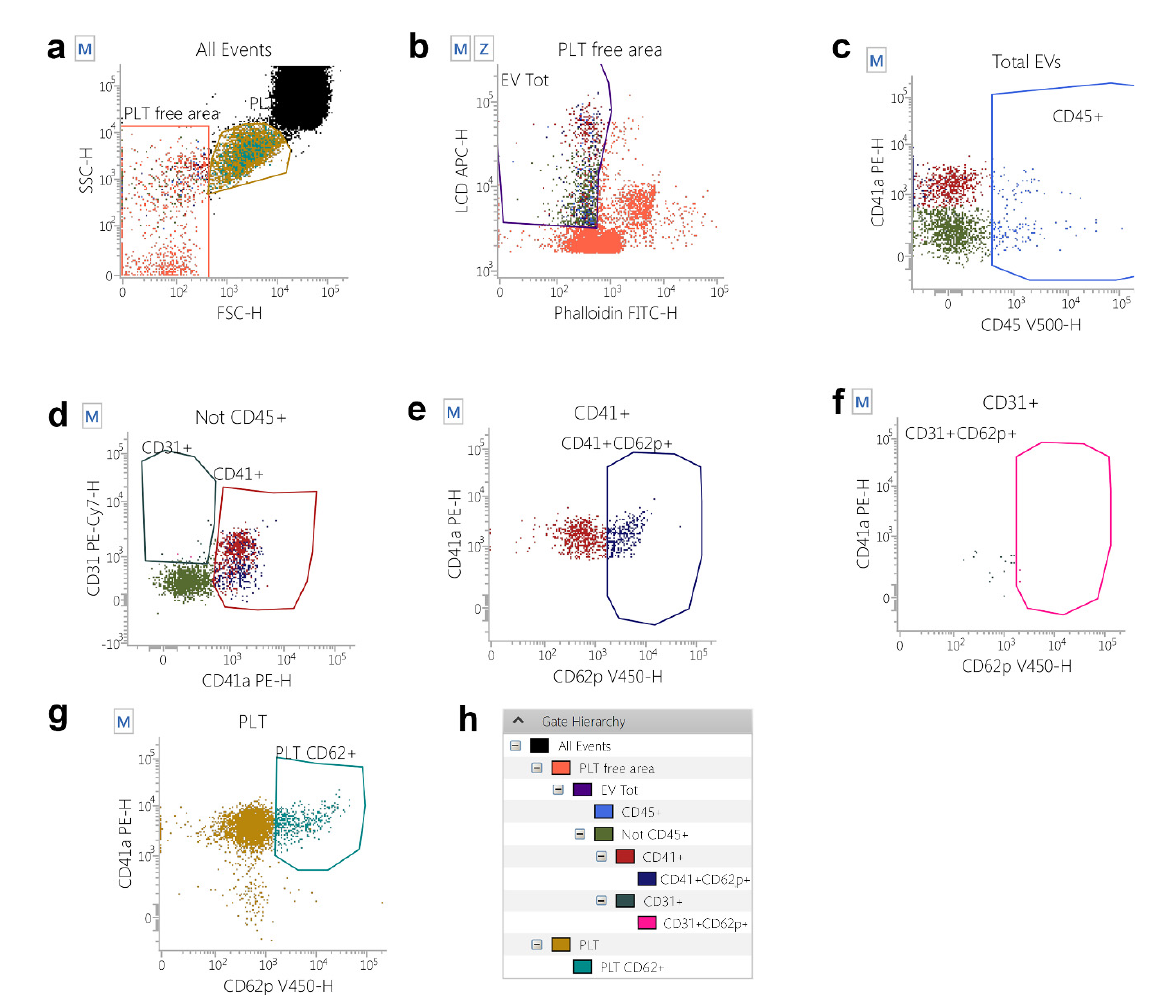
Figure 1. Gating Strategy for extracellular vesicles (EVs) identification and subtyping. ( a ) A platelet- free area region was defined on a Forward Scatter-H/Side Scatter-H dot-plot and, by using platelets (PLT) as a reference population. ( b ) The “Platelet-free area” was shown on a Phalloidin-H/Lipophilic Cationic Dye (LCD)-H dot-plot and EVs were identified as LCD positive/phalloidin negative events. ( c ) EVs (LCD+/Phalloidin- events) were analysed on a CD45-H/CD41a-H dot-plot and CD45+ events were identified as leukocyte-derived EVs. ( d ) A logical gate excluding all the CD45+ events was then obtained, and the resulting population was plotted on a CD31-H/CD41a-H dot-plot. Events showing the CD31+/CD41a+ phenotype were identified as platelet-derived EVs, whereas the CD31+/CD41a- compartment represented endothelium-derived EVs. ( e ) CD31+/CD41a+ platelet-derived EVs, CD31+/CD41a- endothelial-derived EVs ( f ) and whole platelets ( g ) were analysed for activation marker CD62P. ( h ) The applied gating hierarchy is shown as a scheme.